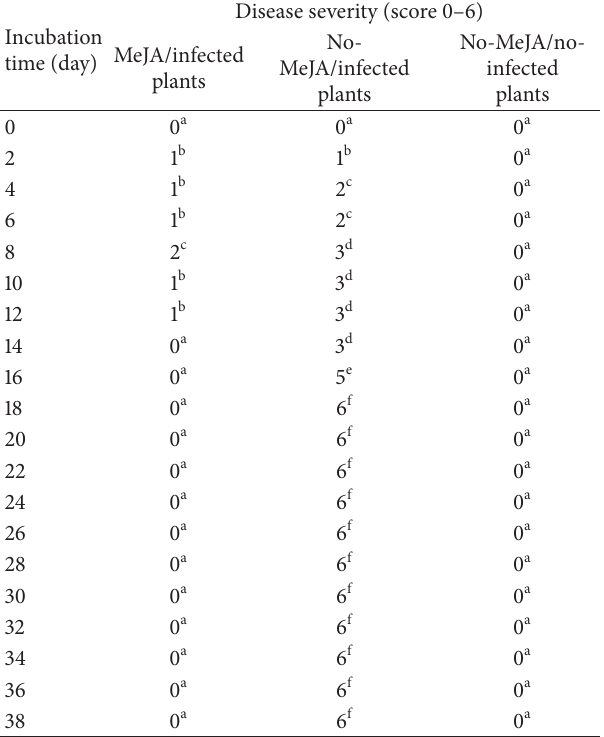
Table 3: Effect of methyl jasmonate treatment on Fusarium wilt severity of cotton